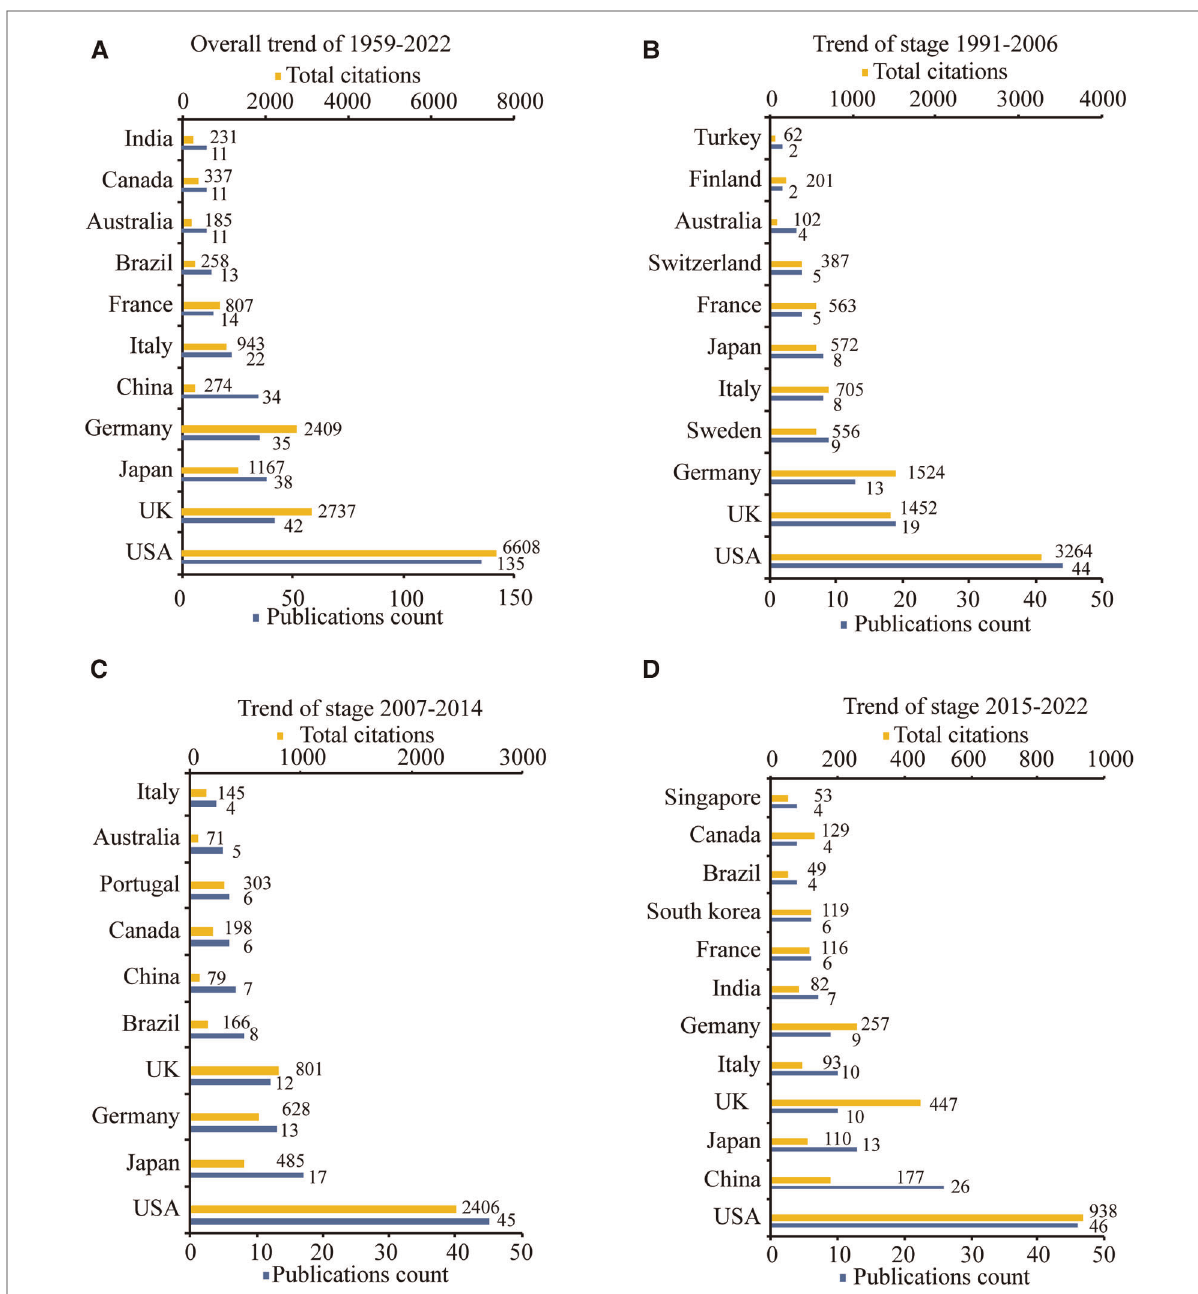
FIGURE 3 The top 10 productive countries/regions ordered by publications count. ( A ) The publications count and total citations of the top 10 countries/regions from 1959 to 2022. ( B ) The publications count and total citations of the top 10 countries/regions from 1991 to 2006. ( C ) The publications count and total citations of the top 10 countries/regions from 2007 to 2014. ( D ) The publications count and total citations of the top 10 countries/regions from 2015 to